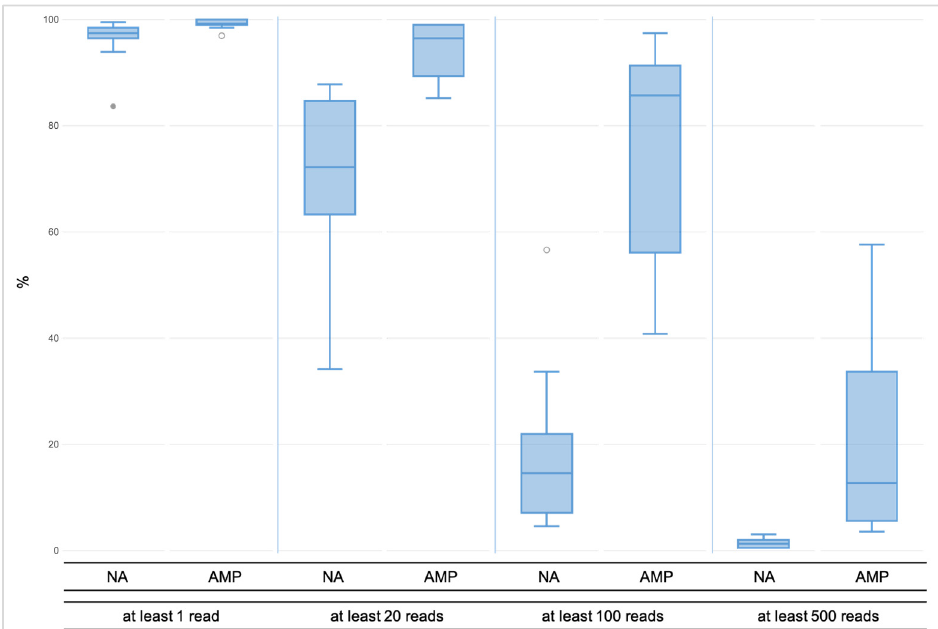
Figure 1. Comparison of the total mapped reads obtained for the unamplified ( a ) and amplified libraries ( b ), together with the number of the reads on target for both groups. The latter was comparable and reached around 60% for both unamplified and amplified libraries but the total number of mapped reads for the amplified libraries was much higher and therefore resulted in higher total coverage. Red dots represent the average coverage per marker for each sample (coverage threshold was set as 50 reads).